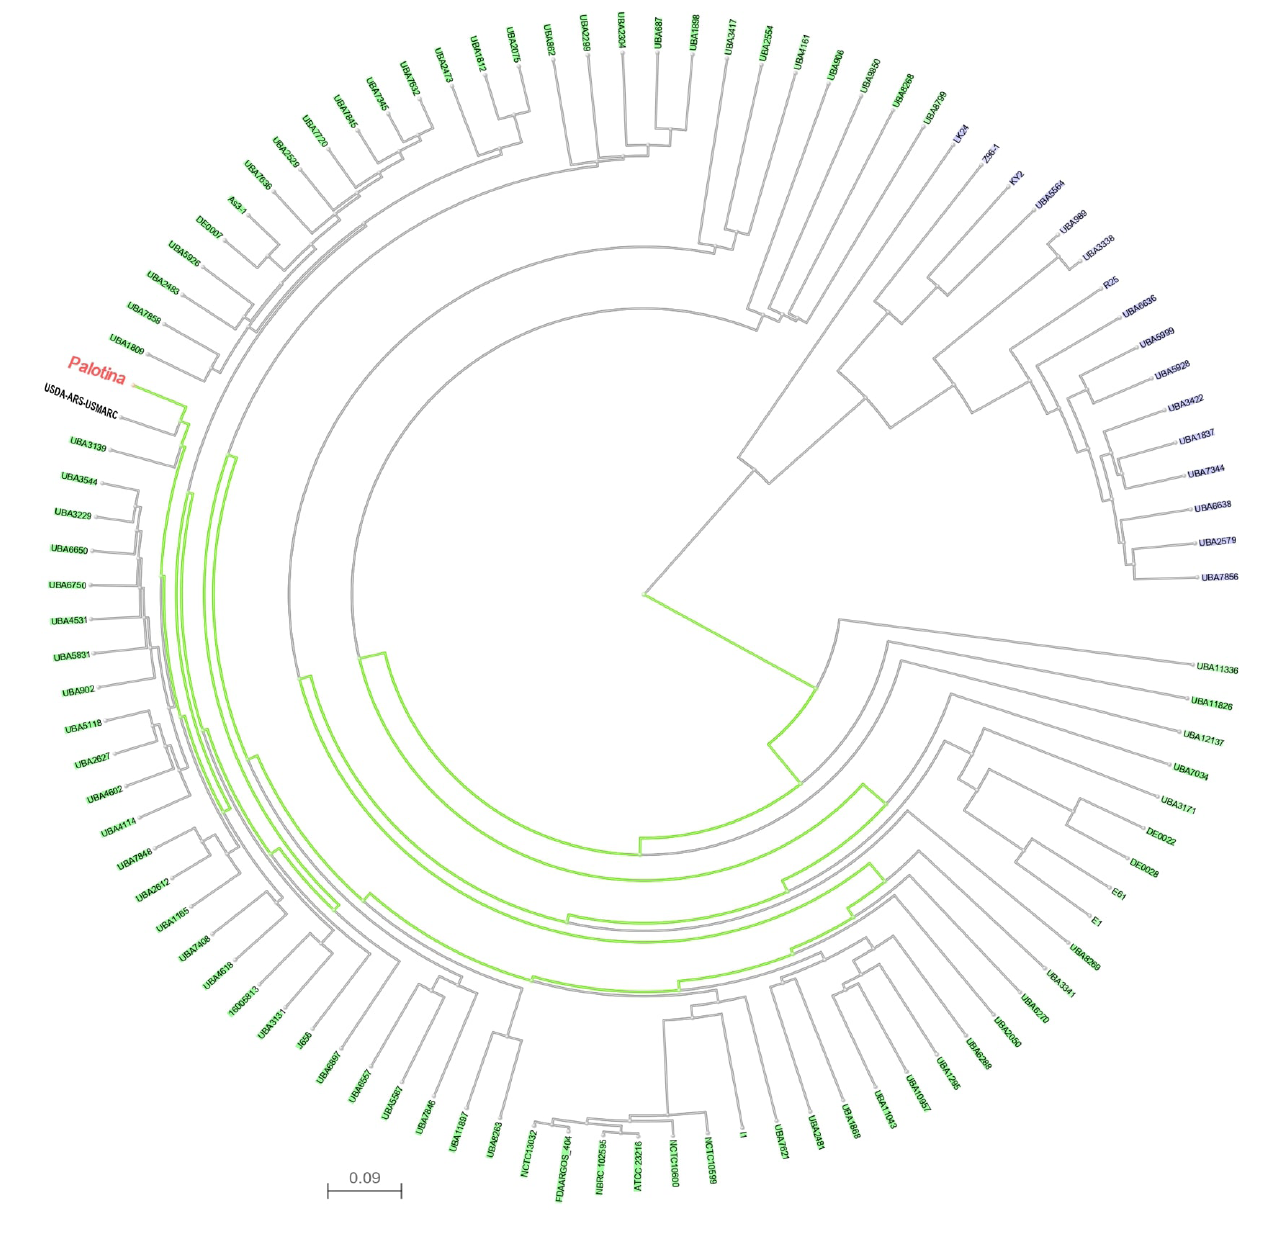
Figure 3 – Phylogenetic relationship among Leclercia strains. In red L. adecarboxylata strain Palotina. The sequences were aligned using the Neighbor- joining method (Saitou and Nei, 1987). The 1,000 resampling bootstrap values are